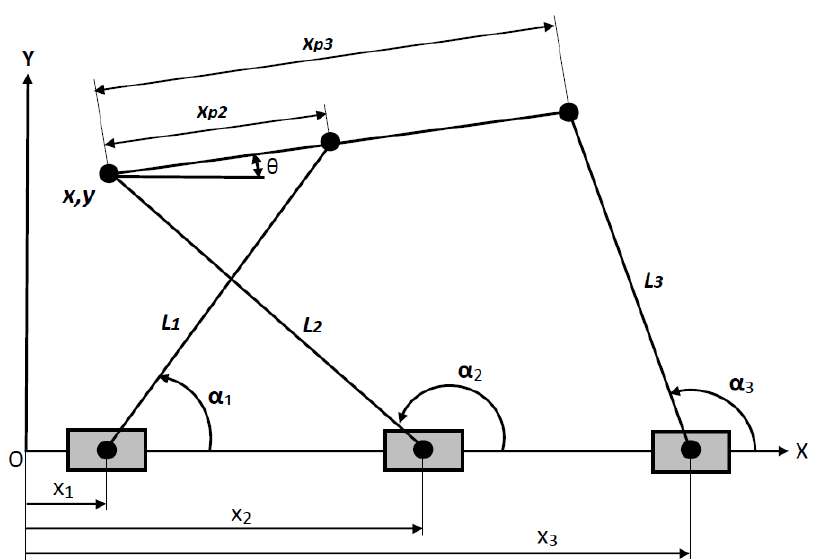
Figure 2. Planar non-symmetric 3PRR manipulator (with Z -axis perpendicular to the paper). A hybrid manipulator composed of two non-symmetric planar 3PRR PMs, as shown in Figure 3, was developed. The two similar PMs are conjugated—one on the bottom and another one on the perpendicular side. This gives a spatial workspace with a redundancy in the translation along the sliders motion direction. This translational redundancy provides a larger workspace in the sliders motion direction. Both the lower and upper platforms use planar PMs as they are easier to design than spatial PMs and more geometrical constraints on the DOFs are expected to minimize the error due to joint errors. This hybrid manipulator can be used for five-axis machining by putting a worktable on the lower module and holding a tool spindle on the upper module. To avoid a redundancy between the rotation of the spindle and the rotation of the upper module, the tool spindle is oriented horizontally. As a result, a five-axis machine is composed. The five-axis machine has three orthogonal translational degrees of freedom as well as two rotational degrees of